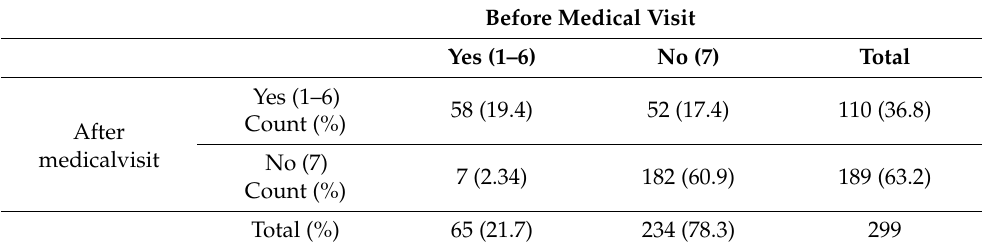
Table 2. Contingency table based on the question: Have you been vaccinated against COVID-19? 1. Yes; 2. Yes, before pregnancy; 3. Yes, during pregnancy; 4. The first dose during pregnancy, the second dose I postponed after pregnancy; 5. The first dose before pregnancy—I postponed full vaccination until later in pregnancy; 6. I postponed the first dose until later in pregnancy, full vaccination later in pregnancy or after pregnancy; 7. No 7. No—Whether the patient has been vaccinated against COVID-19 after a gynaecological visit and whether the patient has been vaccinated against COVID-19 before the medical